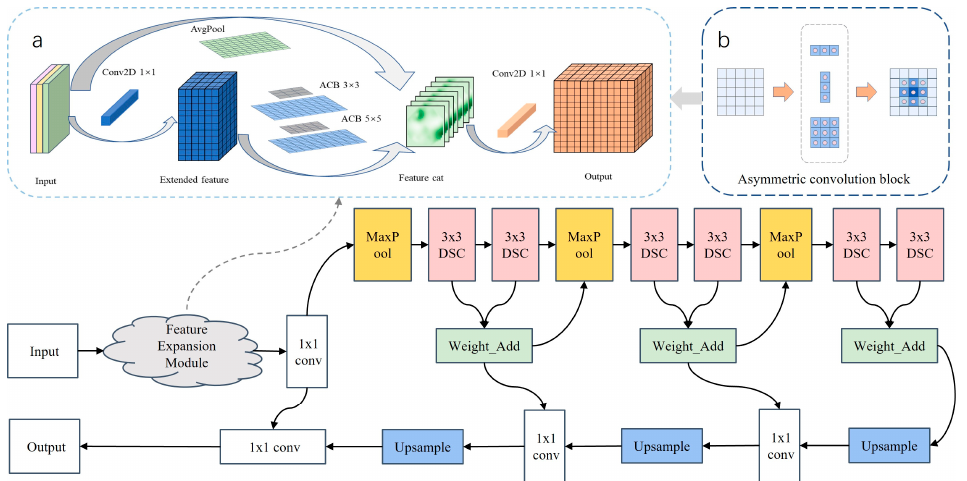
Figure 3. Structure of the lightweight dynamic addition network. ( a ) Feature expansion module. ( b ) Asymmetric convolution block (ACB), depth-wise separable convolution (DSC).